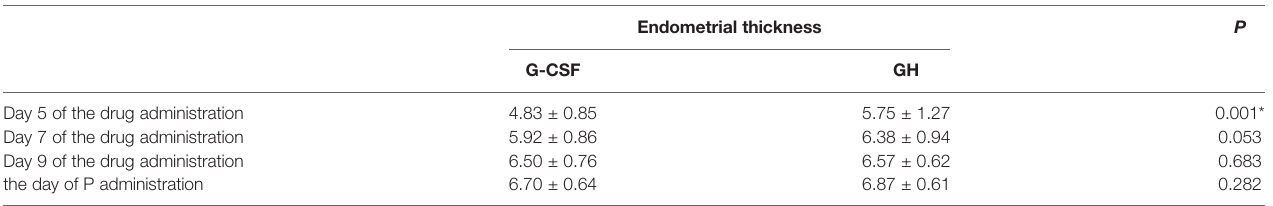
TABLE 3 | The endometrial thicknesses of the G-CSF group and GH